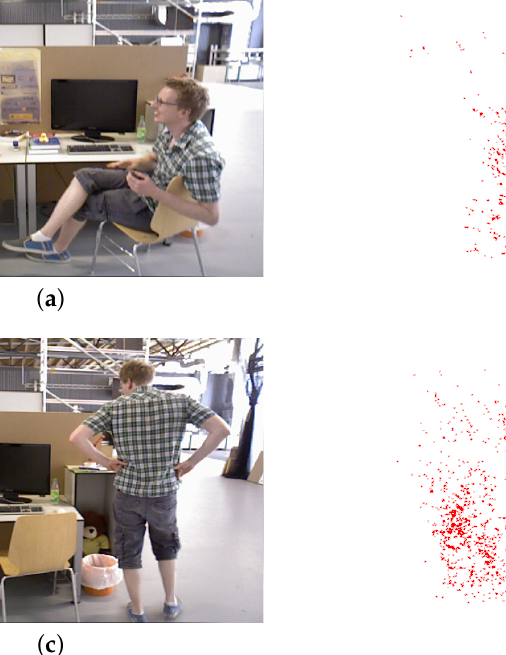
Figure 9. Original ORB-SLAM3 algorithm sparse point cloud map: ( a ) a frame image in a low dynamic dataset; ( b ) sparse point cloud map of a low dynamic dataset; ( c ) a frame in a high-dynamic dataset; ( d ) sparse point cloud map of a high-dynamic